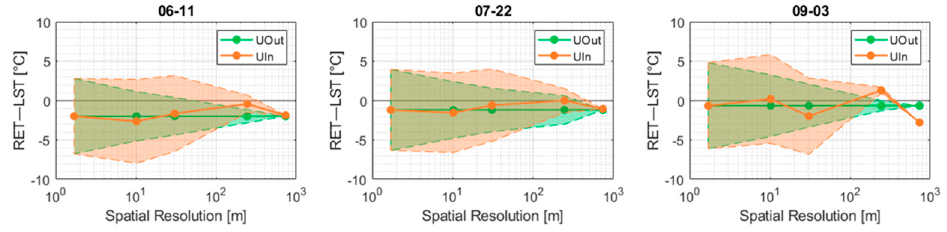
Figure 10. Evolution of the model temperature bias (RET-LST) across different scales: average value (solid line) and standard deviation range (shaded area). (solid line) and standard deviation range (shaded